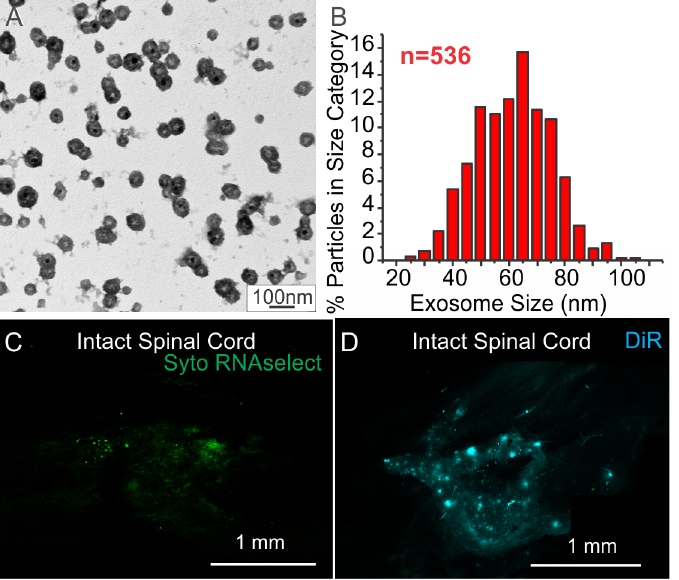
Fig 1. Exosome characterization. A: Electron micrograph of vesicles in exosome fraction from MSC conditioned media sample on formvar coated grid. B: Histogram of size distribution of 536 presumptive exosomes. Note the average size of the vesicles was 59.09 ± 0.58 nm, consistent with exosomes. C-D: Fluorescence micrographs of intact spinal cord directly injected with exosomes fractions from SytoRNAse (C) and DiR (D) labeled MSCs before perfusion. Note that the presence of detectable levels of 488nm (SytoRNAse) and 650nm (DiR) fluorescence indicates the presence of both RNAs and lipids in the exosome fractions. Scale bar in A indicates 100nm. Scale bars in C &D indicate 1